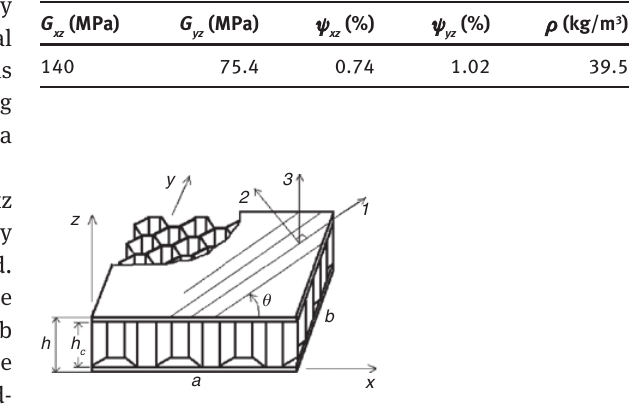
Figure 1: Sandwich panel and material